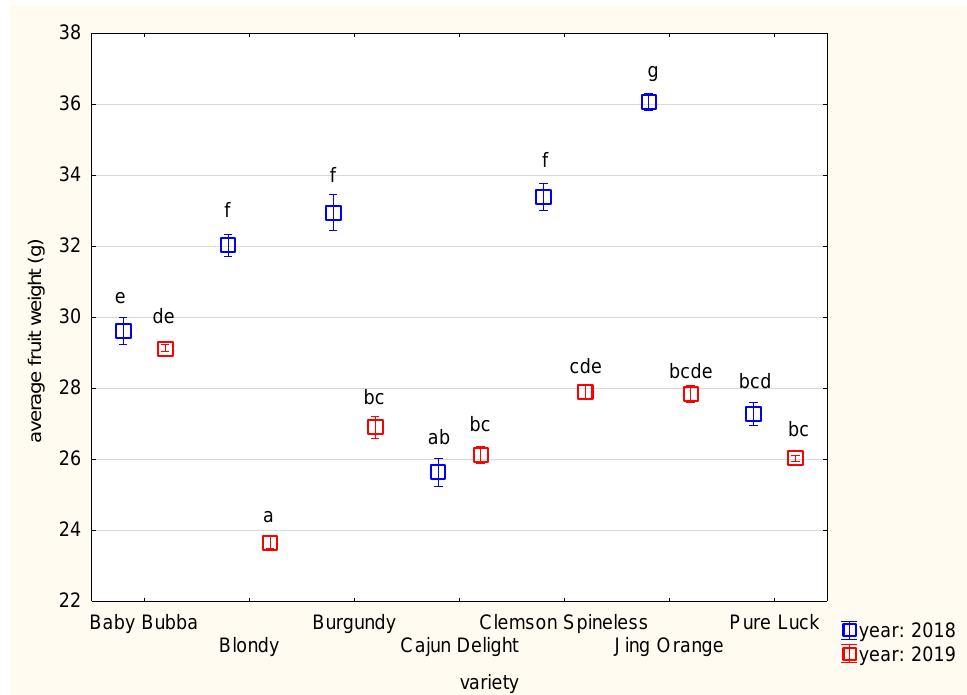
Figure 1. Average weight of okra fruits by Scheffe test (error bars represent SD; different letters among cultivars and years show statistically significant differences at the level p < 0.05).